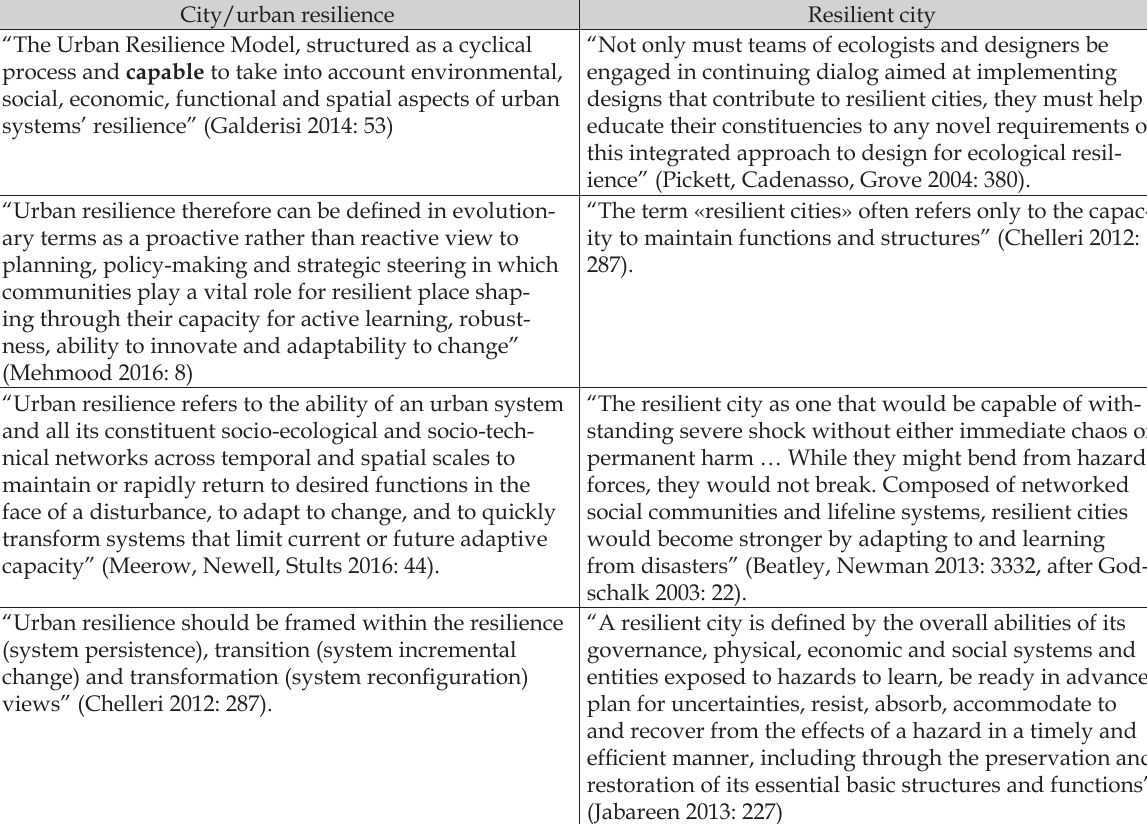
Table 1. Selected approaches to the resilient city and city